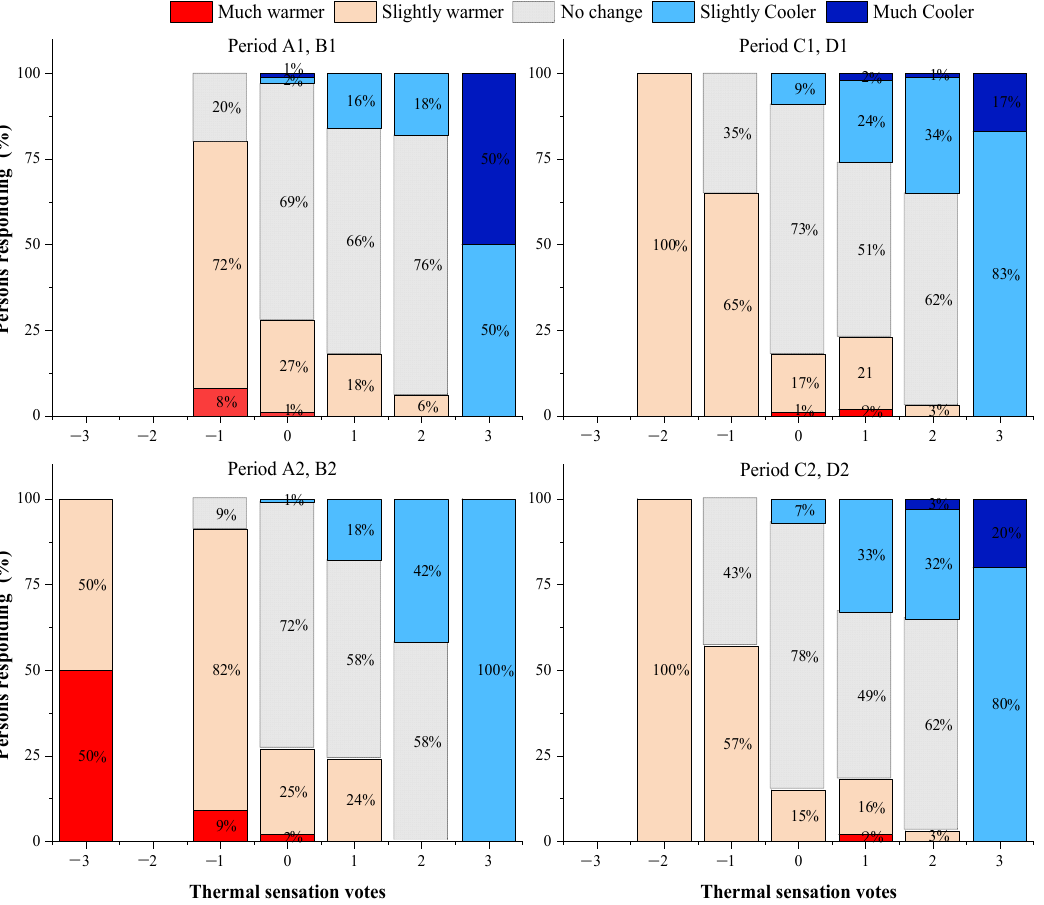
Figure 9. Cross tabulation of thermal preference votes on thermal sensation scale. Note: Since there was no significant difference in the TPV values of the two classes in the morning/afternoon, the data of the two classes in the morning/afternoon were combined.